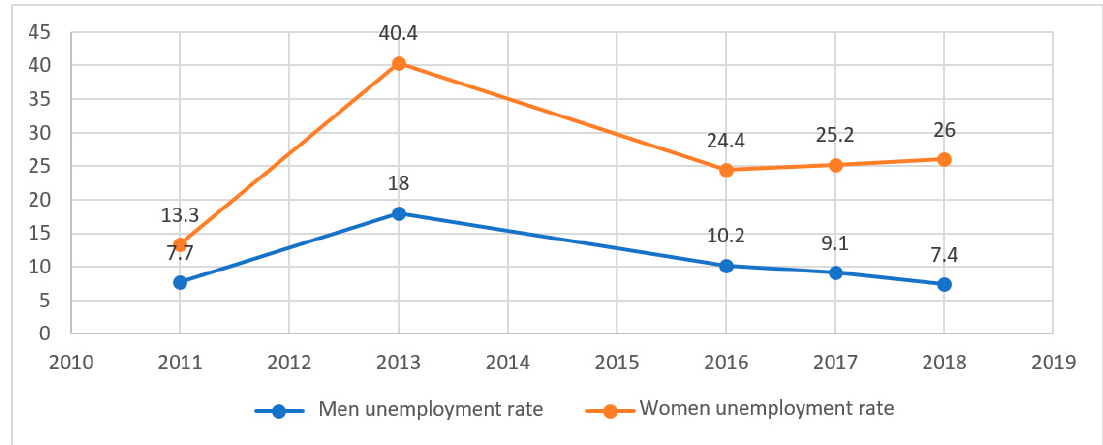
Figure 3. Evolution of the unemployment rate by gender. Source: Authors, based on ANSD data.